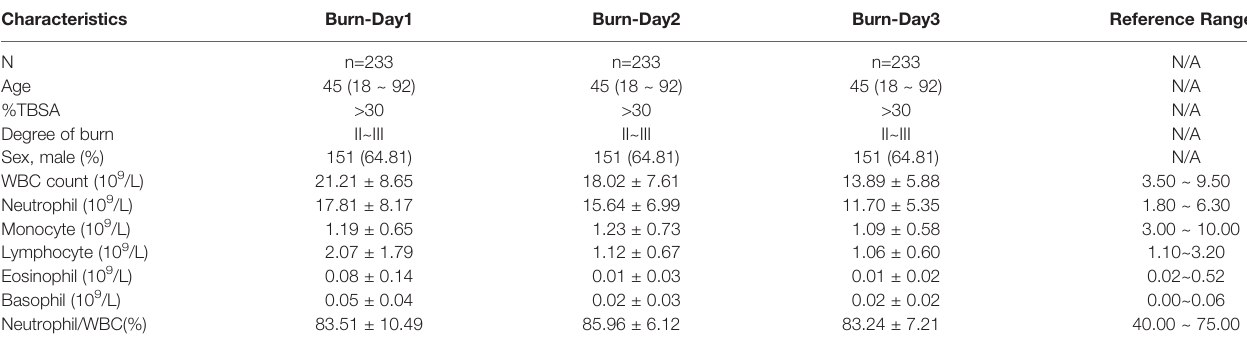
TABLE 1 | Characteristics of severe burned patients over the last 10 years.